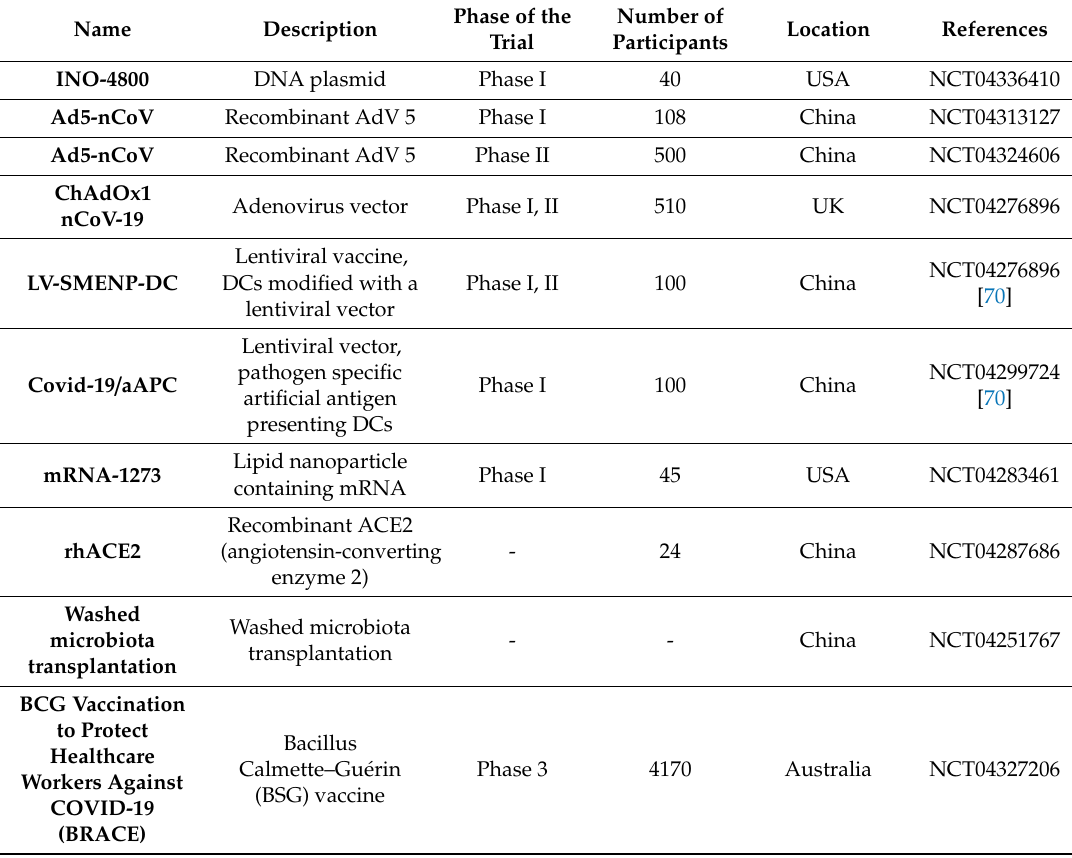
Table 1. Selected clinical studies on vaccine research against SARS coronavirus 2